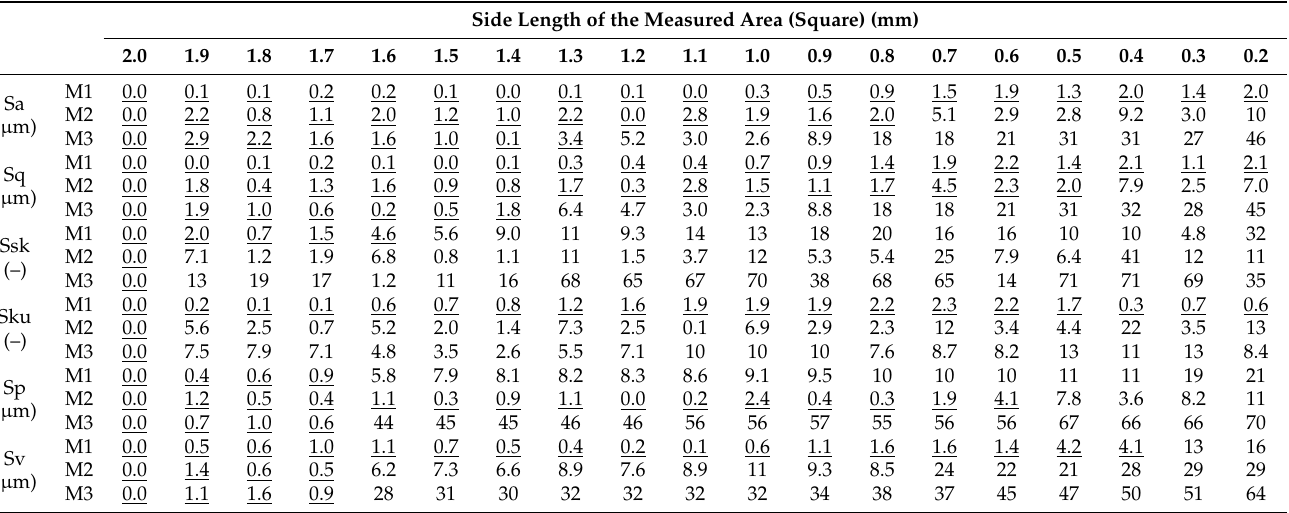
Table 3. Changes in the roughness values (%) compared to the values measured on the area 2 × 2 mm. Side Length of the Measured Area (Square)